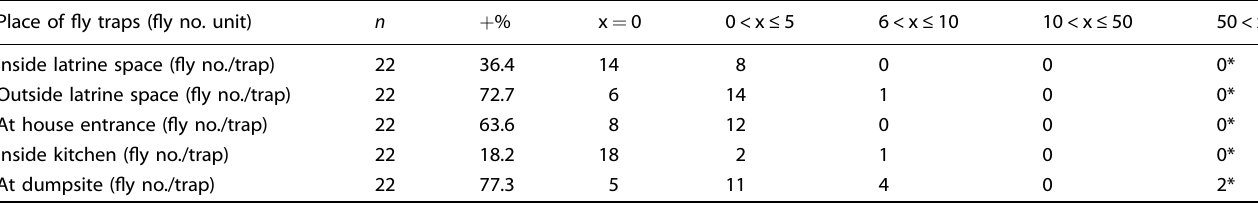
Table 6. E. coli concentration of fl ies (CFU/ fl y) at fi ve types of places. Place of fl ies Outside latrine space (CFU/ fl y) Inside kitchen (CFU/ fl y)